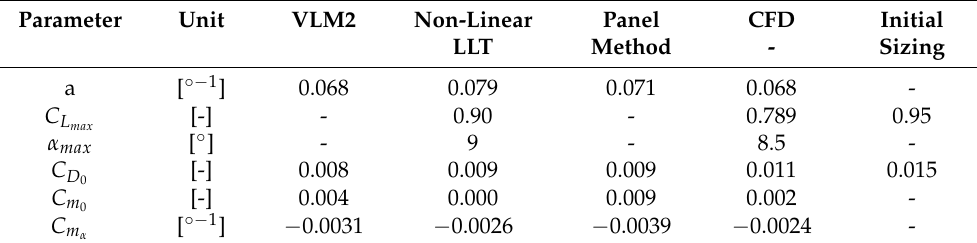
Table 10. Comparison of aerodynamic